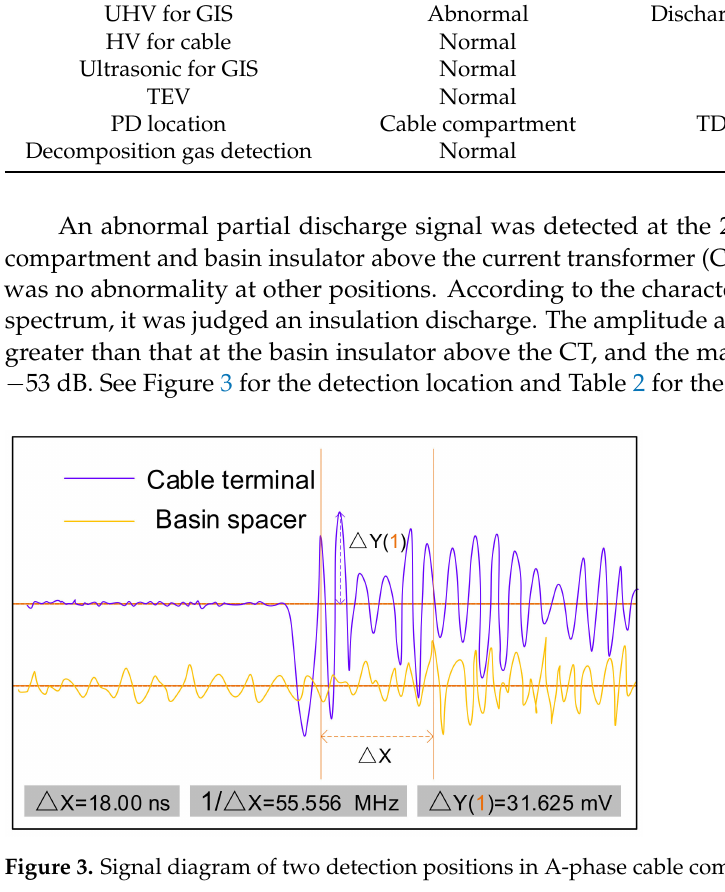
Figure 3. Signal diagram of two detection positions in A-phase cable